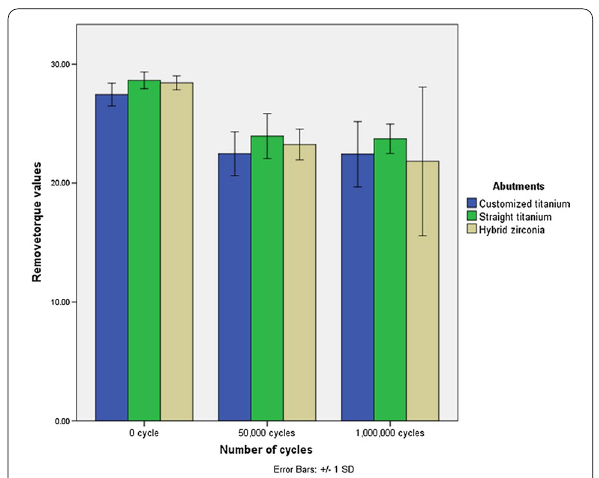
Fig. 4 Comparison of the mean removal torque value between types of abutments at 0 cycle (initial), 50,000 cycles, and 1,000,000 cycles. The zero-cycle group is significantly higher than other groups. ( P -value < 0.001)